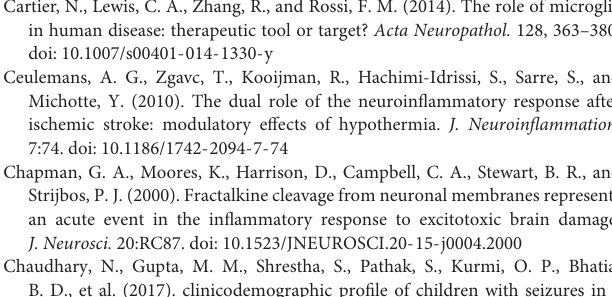
FIGURE S1 | Bioenergetic profile of microglial cells. (A) The glycolysis of microglia ± 10 ng/ml of LPS as ECAR parameter of the seahorse experiment reported in Figure 3F , indicates that the LPS treatment doubled the basal value. (B) The effect of LPS on microglia is reported as phenotype plot. This plot, where both ECAR and OCR are reported on the X and Y -axis, respectively, indicates that the LPS sample (open triangle) is more glycolytic and less aerobic than the untreated one (open circle). Interestingly, while the untreated responds to stressors as expected (gray circles), by increasing both OCR and ECAR, the LPS sample is quite insensitive to drugs treatment (gray triangles). This could be ascribed to a poor and probably maximal basal mitochondrial activity. In the figure a representative experiment; values reported in the plot are the means of at least 8 replicates ± SD. FIGURE S2 | Bioenergetic profile of microglial cells. The mitochondrial respiration of microglia, obtained by means of OCR by seahorse experiments, ± 100 nM of CX3CL1 (24 h of treatment; black and empty symbols, respectively). Arrows indicate the addiction of drugs used to specifically target the mitochondrial function (i.e., oligomycin, FCCP, rotenone + antimycin, in order of addiction). Chemokine treatment does not affect the energetic profile. In the figure a representative experiment; values reported in the plot are the means of at least 8 replicates ± SD. FIGURE S3 | Energetic profile of LPS-treated microglia ± CX3CL1 treatment. LPS sample (10 ng/ml, open triangle) and LPS + CX3CL1-treated one (10 ng/ml + 100 nM, open square). Arrows indicates the addiction of drugs used to specifically target the mitochondrial function (i.e., oligomycin, FCCP, rotenone + antimycin, in order of addiction). In the figure a representative experiment is shown as OCR (A) and ECAR (B) measurements. Histograms from panels (C–H) (LPS sample, black square and LPS + CX3CL1-treated sample, open square) are belong to panels (A,B) data, according to Agilent Mito Stress Report generator. Values reported in the plot are the means of at least 8 replicates ±